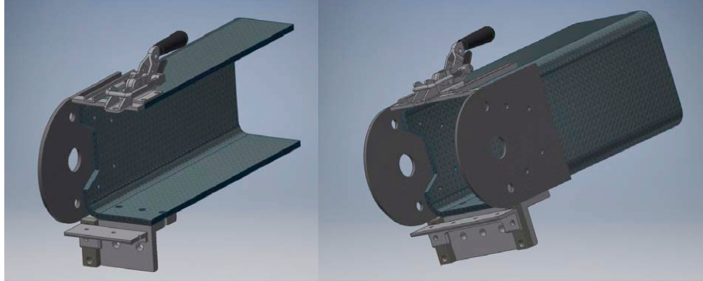
Figure 3. Material guidance system (cut section and completed) for the open source w aste plastic